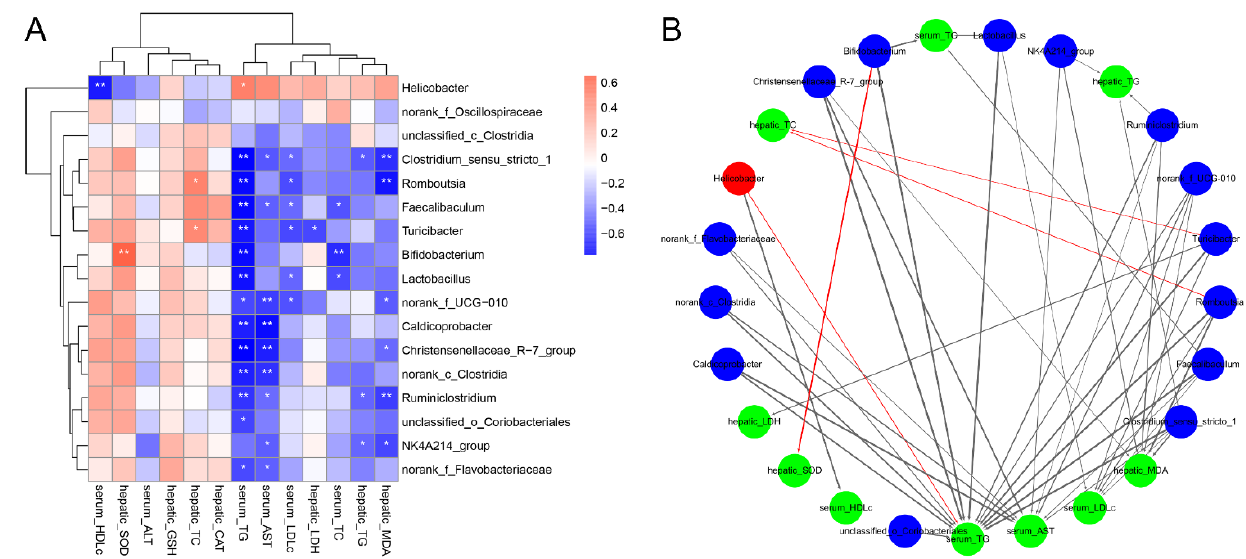
Figure 6. Correlation of intestinal microbes with biochemical parameters. ( A ) Heatmap of correlation between the biochemical parameters and the key microbial phylotypes at the genus level. ( B ) Correlation network between the biochemical parameters and the key microbial phylotypes. Red nodes: the key intestinal microbial phylotypes reduced by high-dose GA intervention; blue nodes: the key intestinal microbial phylotypes increased by high-dose GA intervention; green nodes: the biochemical parameters. The red lines represent positive correlations, and the black lines represent negative correlations. Line widths represent the strength of correlation. Only the significant edges were drawn in the network (|r| > 0.6, FDR adjusted * p < 0.05, ** p < 0.01).